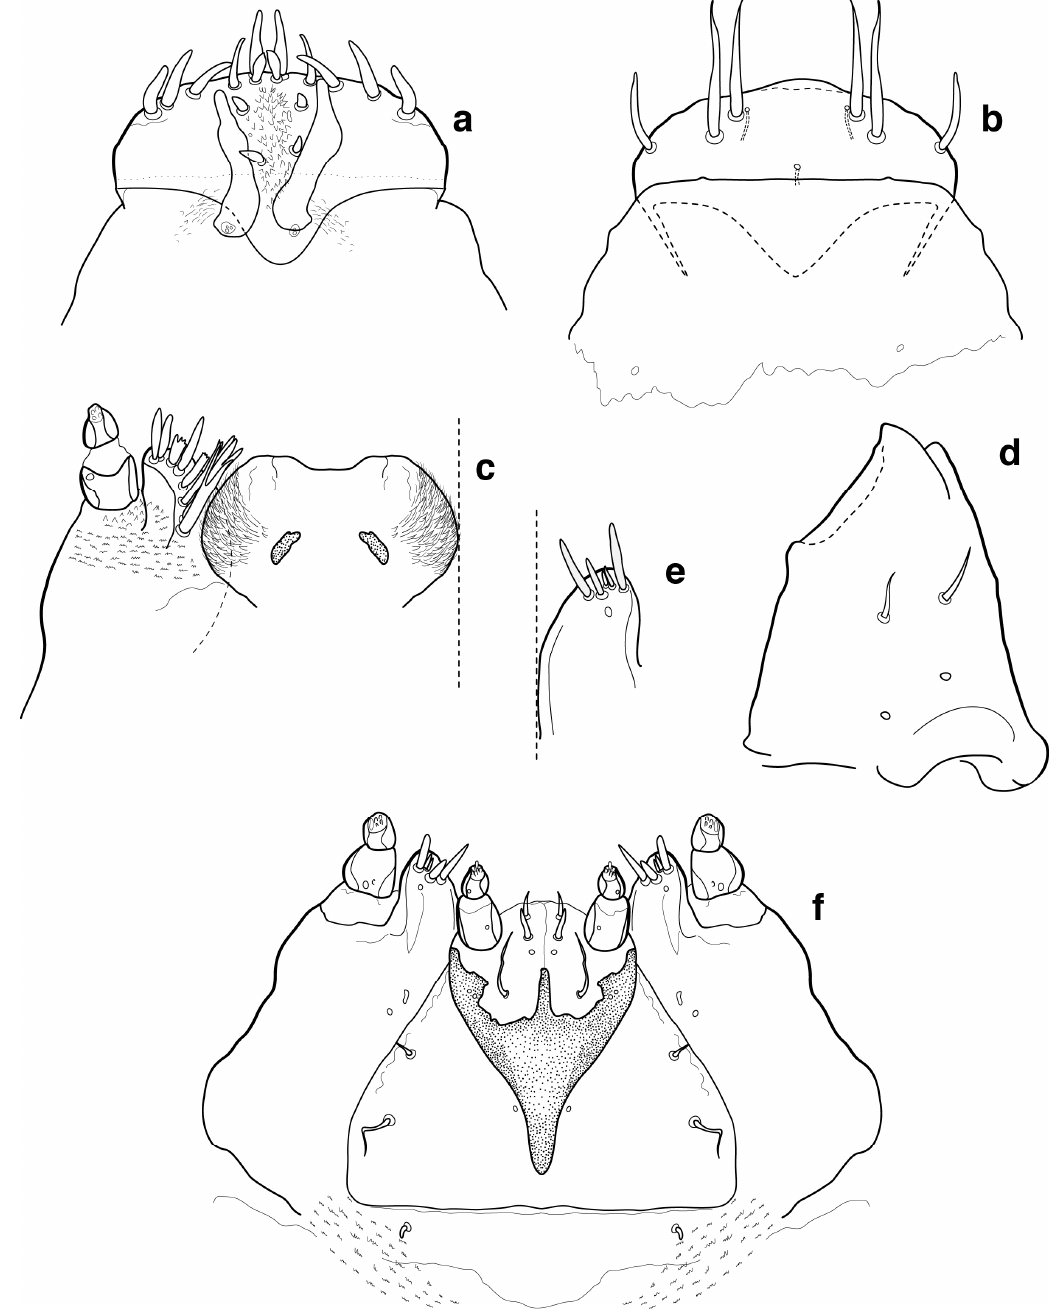
Figure 66. Probably Mesocordylus sp. mouthparts: ( a ) epipharynx; ( b ) clypeus (incomplete) and labrum; ( c ) detail of hypopharynx, mala and maxillary palp, dorsal view; ( d ) mandible; ( e ) detail of mala and ventral malar setae; and ( f ) labio-maxillary complex, ventral view.